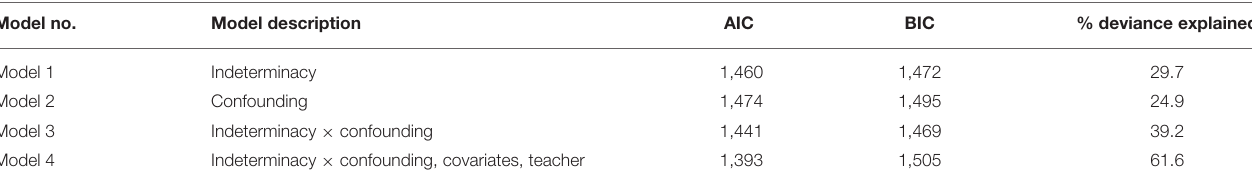
TABLE 3 | Relative model fit and explained deviance for the four fitted general additive (mixed) models. Model